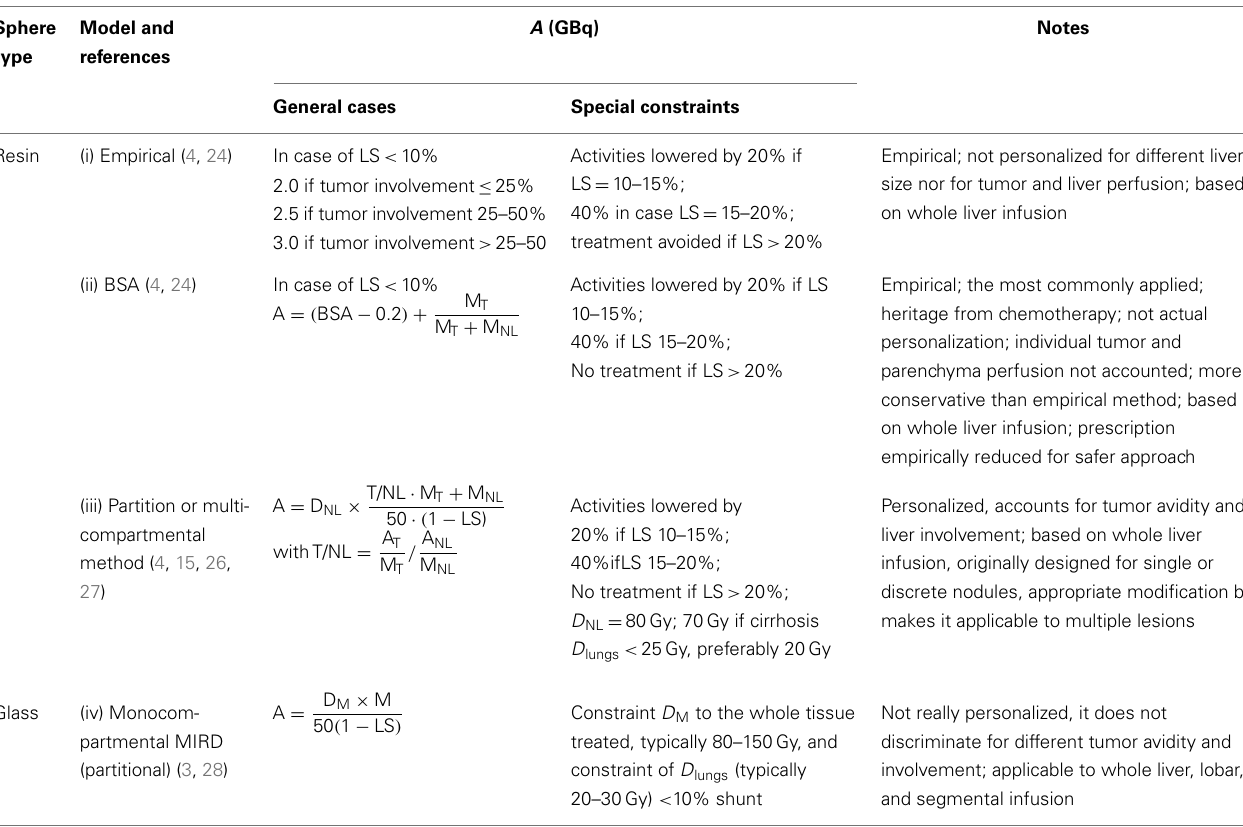
Table 2 | Methods to determine the activity to be injected according to device user manual